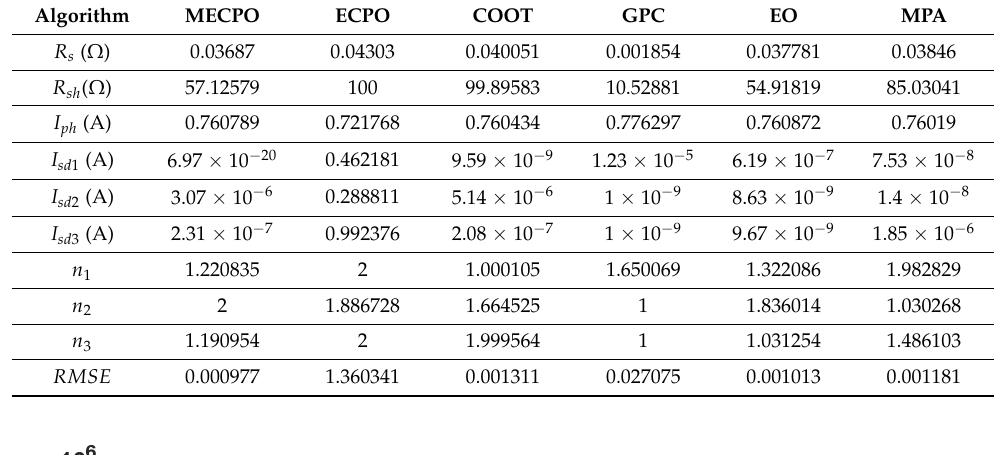
Table 12. Calculated parameter in case of the TDM obtained by the proposed algorithm and other recent techniques.